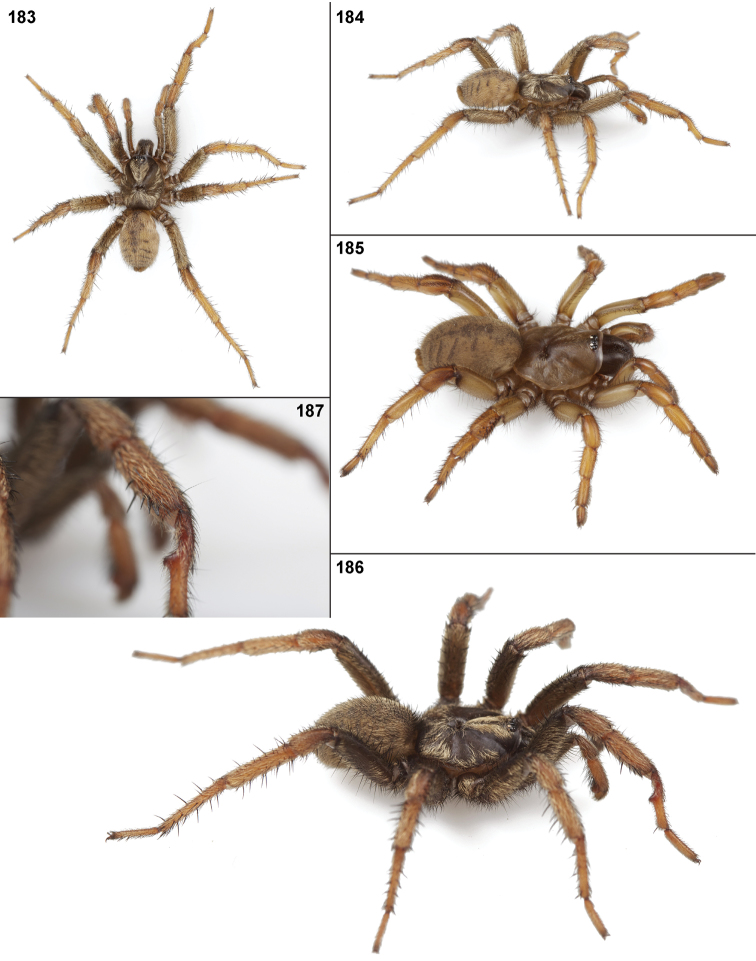
Photographs of live Aptostichus barackobamai sp. n. 183, 184 male paratype specimen from Tehama Co. (MY3805) 185 female specimen from Tehama Co. (MY3804) 186, 187 male specimen from Marin Co. (AUMS001).